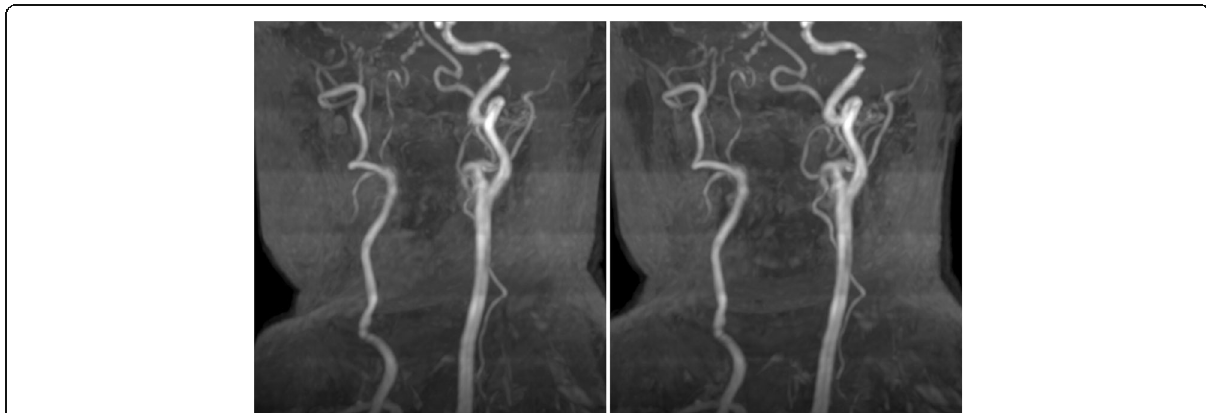
Fig. 3 Magnetic resonance angiography. Stereoscopic images of 3D time-of-flight magnetic resonance angiography showing the absence of the cervical segment of the right internal carotid artery. The ipsilateral vertebral artery appears to arise from the common carotid